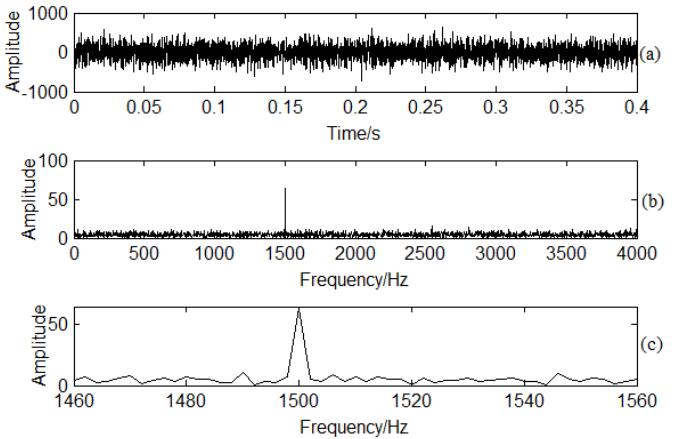
Figure 5. Frequency spectrum analysis: ( a ) Time domain signal for the noise interference signal; ( b ) Spectrum analysis for the noise interference signal; ( c ) Enlarged frequency area for the carrier frequency